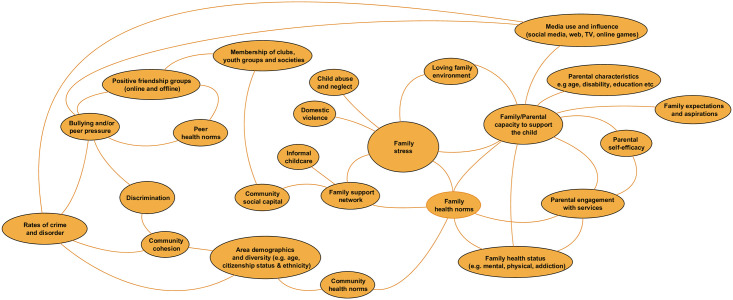
The social domain.